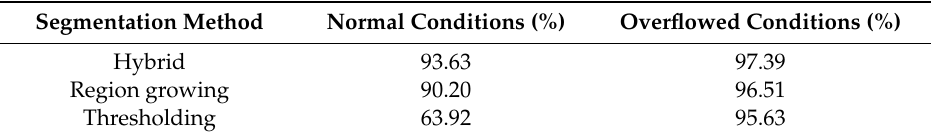
Table 2. Jaccard index for normal and overflowed